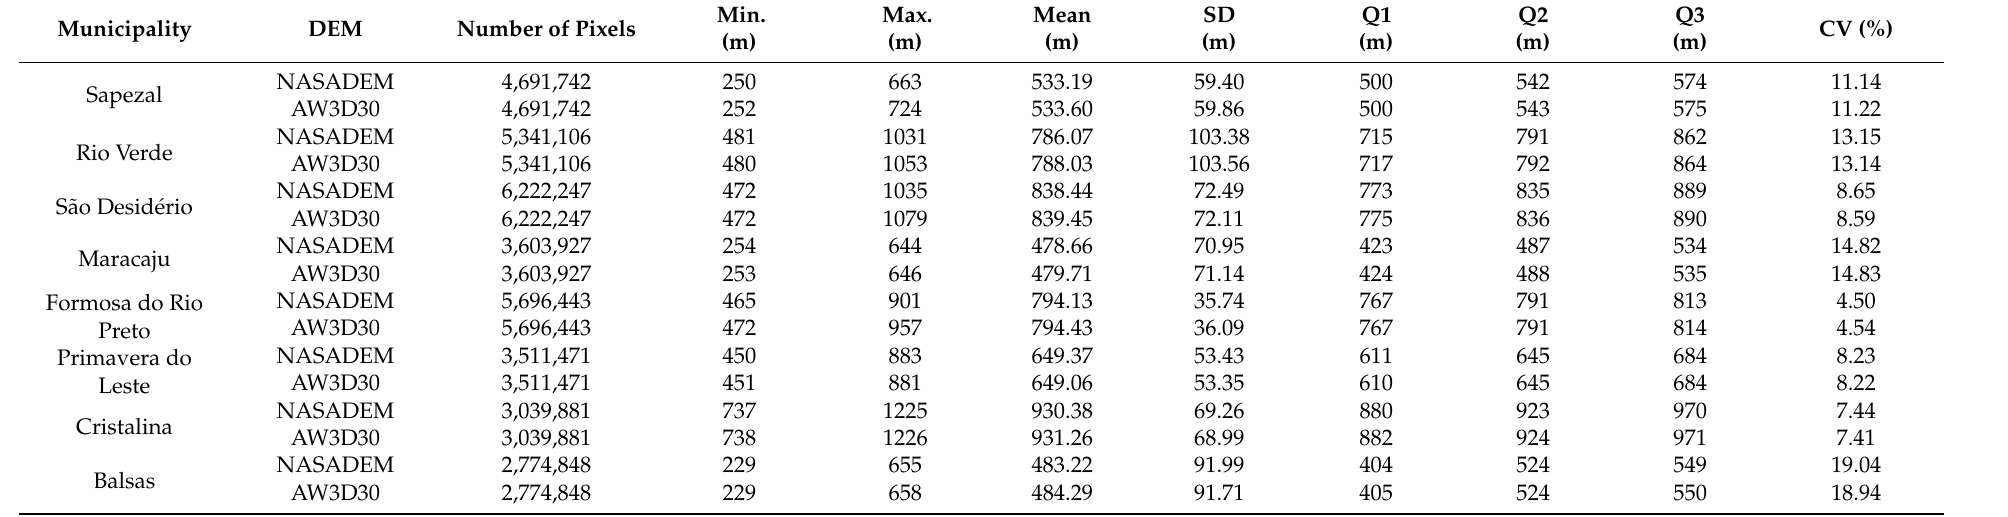
Table 10. Quantitative measurements of altitude (m) extracted from NASADEM_HGT and AW3D30 over eight municipalities of the Cerrado with highest grain production. Min. = minimum altitude (m); Max. = maximum; SD = standard deviation; DEM = digital elevation model; Q1 = first quartile; Q2 = second quartile; Q3 = third quartile; and CV = coefficient of